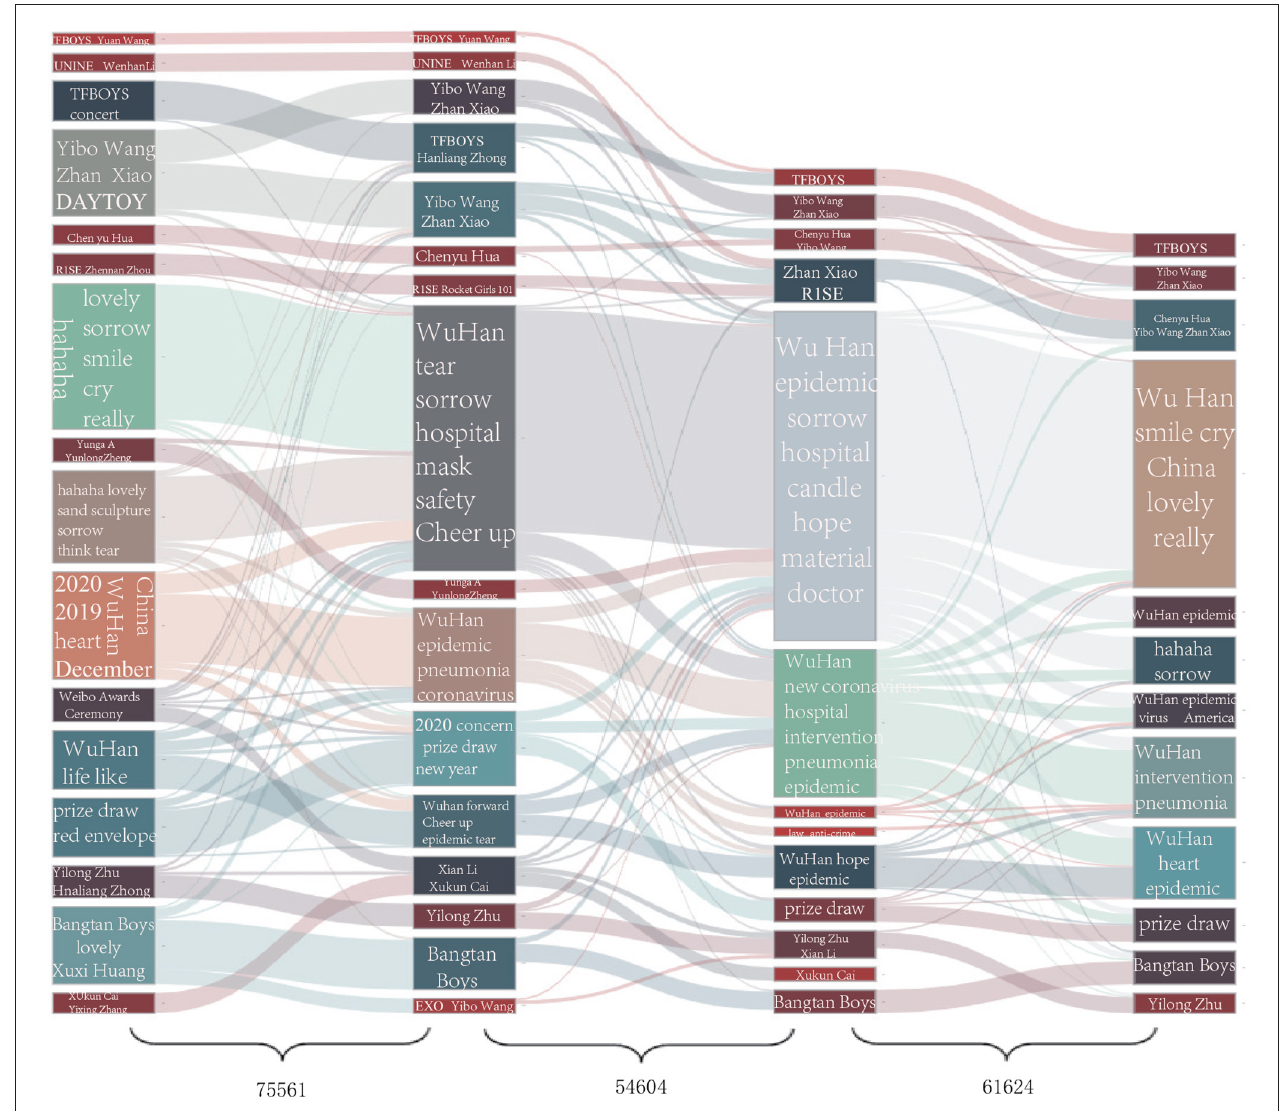
FIGURE 5 | Evolution of network communities during the COVID-19 outbreak in Wuhan. Flows with less than 100 users are filtered, and the non-translated plots are shown in Supplementary Figures 4–8 .